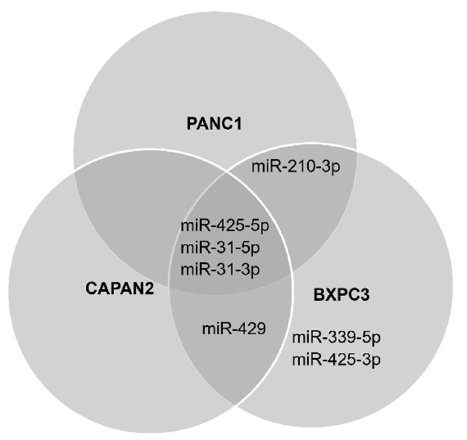
Figure 3. miRNAs differentially expressed in at least one PDAC cell line. The figure exhibits the statistically significant miRs specific to each cell line and which of those were shared. Significant expression of miR-31-5p, miR-31-3p, and miR-425-5p was observed in all three PDAC cell lines. Meanwhile, CAPAN2 and BXPC3 both significantly expressed miR-429. miR-210-3p exhibited sig- nificance in the PANC1 and BXPC3 cell culture models while miR-339-5p and miR-425-3p were the only miRs to be significantly expressed in a single cell line, BXPC3.